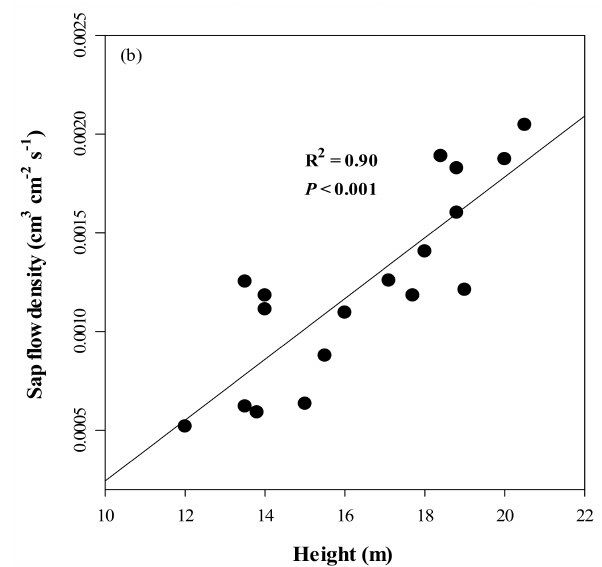
Figure 5. The relationship between sap flow density ( SFD ) and ( a ) tree diameter at breast height (DBH); and ( b ) tree height.